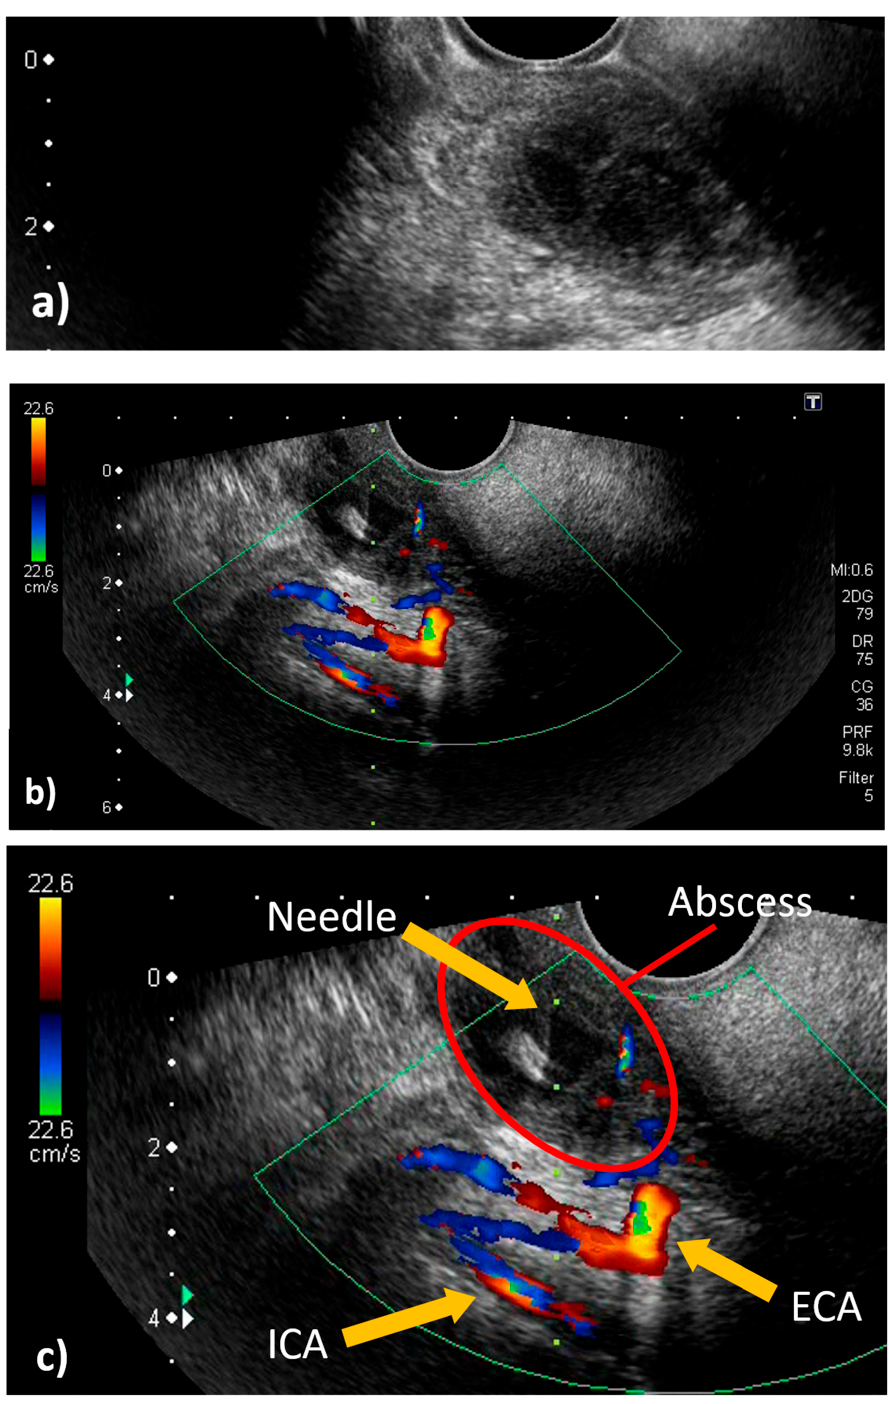
Figure 4. Transoral pharyngeal ultrasonography (TOPU). ( a ) TOPU with B-mode. ( b ) TOPU with color Doppler. The left side of the image is the head side, and the right side is the foot side. TOPU shows the internal carotid artery (ICA) under the abscess at a depth of 30–40 mm and the external carotid artery (ECA) just under the abscess at a depth of 20–30 mm. The branches of the ECA surround the head side of the abscess. The tip of the needle is inserted at the center of the abscess in the hypoechoic space. The vertical green dotted line indicates the direction in which the needle advances; this guiding line system is incorporated in the ultrasound machine (Aplio500). ( c ) Schematic image. The periphery of the abscess is indicated by the red circle. It is easy to differentiate between the ICA and ECA because the branch arteries are visualized along with the ECA.